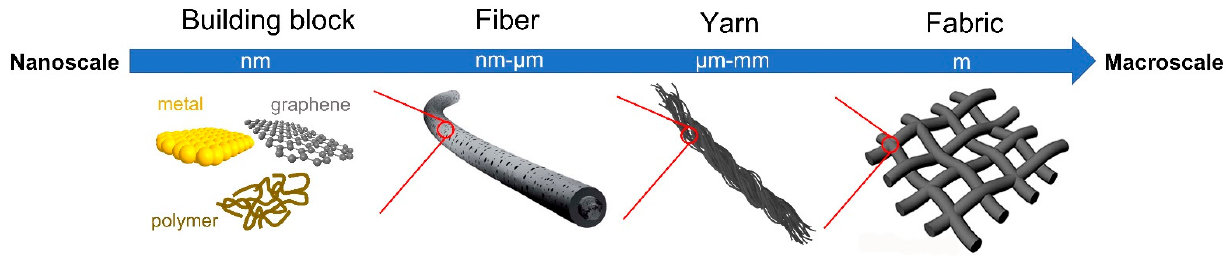
Figure 1. Schematic representation of hierarchical structures across multiple length scales in